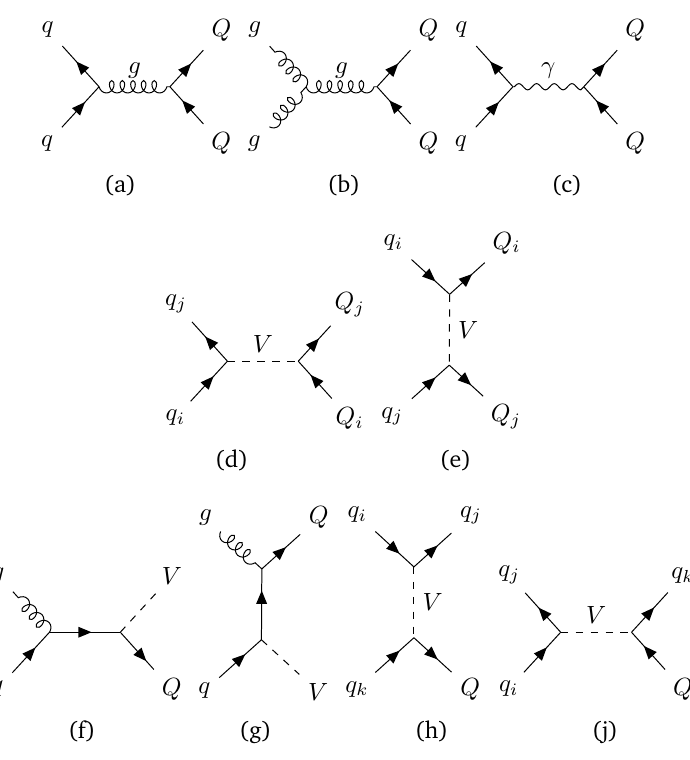
Figure 1: Leading-order Feynman diagrams for production of VLQs Q . The top row (a–c) shows VLQ pair-production diagrams via strong and EM interactions, which do not depend on κ . The second row (d–e) shows pair-production of VLQs via a weak boson V ∈ { W , Z , H } , which may lead to different-flavoured VLQs in the final state. The third row (f–i) shows single-production of Q in association with a weak boson or SM quark q